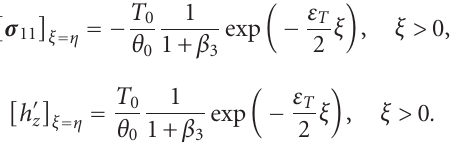
Figure 3.1 represents variations of displacement against distance for two di ff erent times η = 0 . 25 and η = 0 . 95. It is observed that the displacement curve is continuous and it grad- ually increases with distance. The graph shows negative value in the range 0 <ξ < 0 .